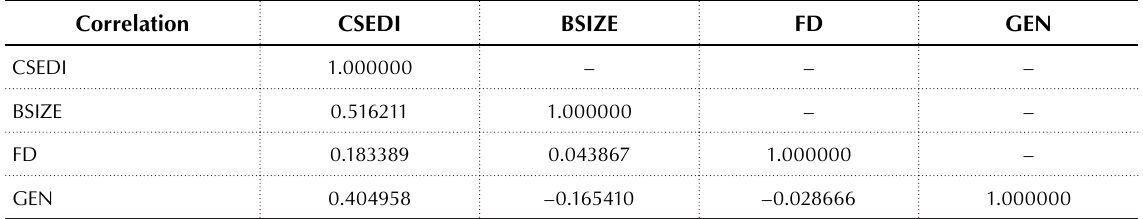
Source: Calculated by the researchers using the E-VIEWS 9